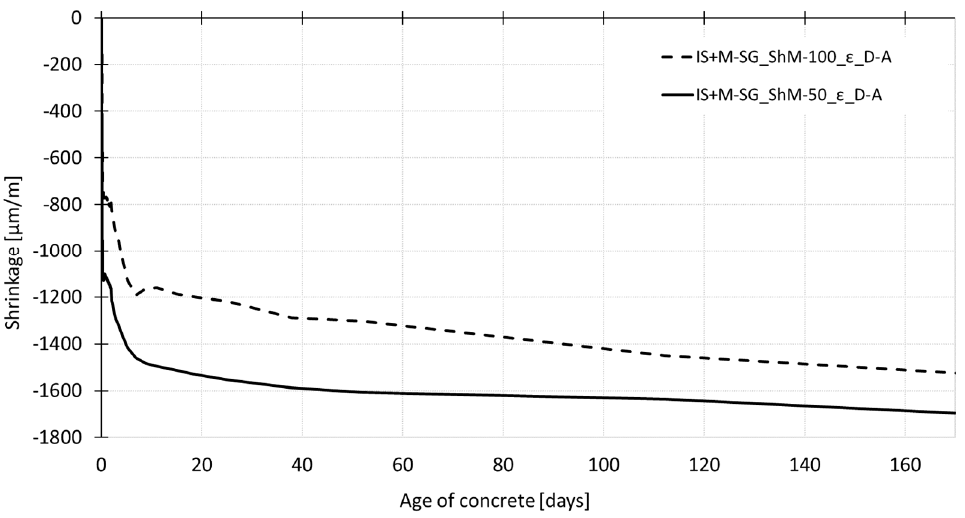
Figure 9. Process of early-age shrinkage recorded by inductive sensor of shrinkage molds (IS_ShM) of di ff erent dimensions and process of internal temperature (T in ) of specimens cured under dry air conditions.